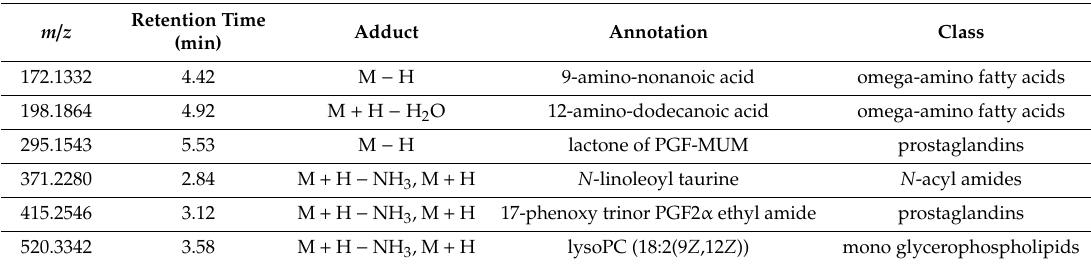
Table 2. Annotation of the features involved in the discrimination between asthmatic and healthy